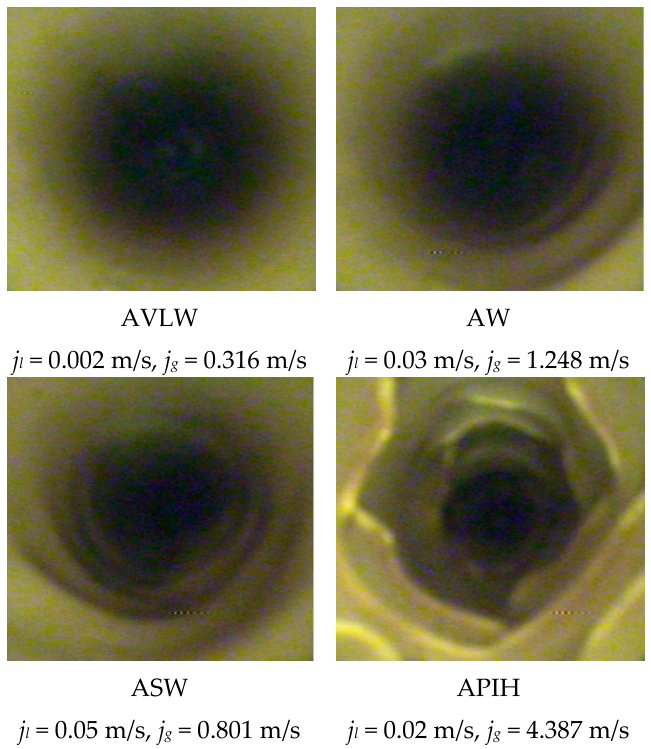
Figure 19. Effect of flow parameters on wave formation in oil film with the viscosity of 0.335 Pas. Energies 2020 , 13 , x FOR PEER REVIEW